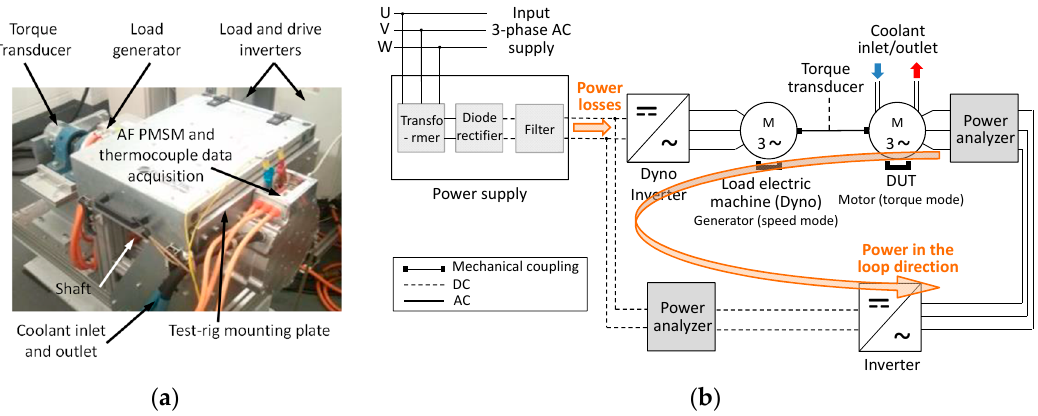
Figure 1. Test of the PMSM motor based on axial flux technology: ( a ) the AF PMSM prototype under test; ( b ) Schematic of the experimental set-up facility.